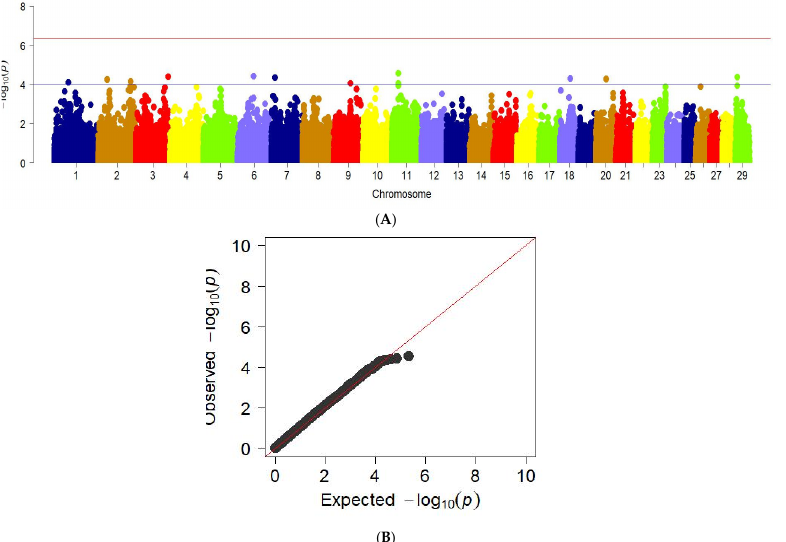
Figure 7. Manhattan plots of WGS for meat output on bones with significance thresholds indicated at − log10 p > 4.5 × 10 − 7 . B The quantile-quantile (QQ) plots for the studied quality trait. Panel ( A ) shows the chromosome regions associated with bone meat output using ~150,000 imputed sequence SNPs. The panels ( B ) have shown the QQ plots for meat output on bones trait. 5. Discussion The discovery of single nucleotide polymorphism (SNP) and subsequent genotyping of a large number of animals made it possible to conduct a large-scale analysis to under- stand the biological processes underlying the variability of animal populations. The avail- ability of SNP panels for the entire genome made it possible to implement genomic pre- diction in many livestock species [40,41]. Unlike traditional quantitative trait locus map- ping strategies, GWAS opens up new opportunities for the effective use of mongrel cattle populations for high-resolution loci mapping with even modest effects underlying im- portant productive traits [42]. In addition, developing sequencing technologies provides new opportunities for improving the accurate mapping of quantitative trait loci. Given the relatively high cost of sequencing, there is a tendency for genotyped animals (mainly genotyped by SNP density from 10 to 700 thousand) to be accurately calculated to the